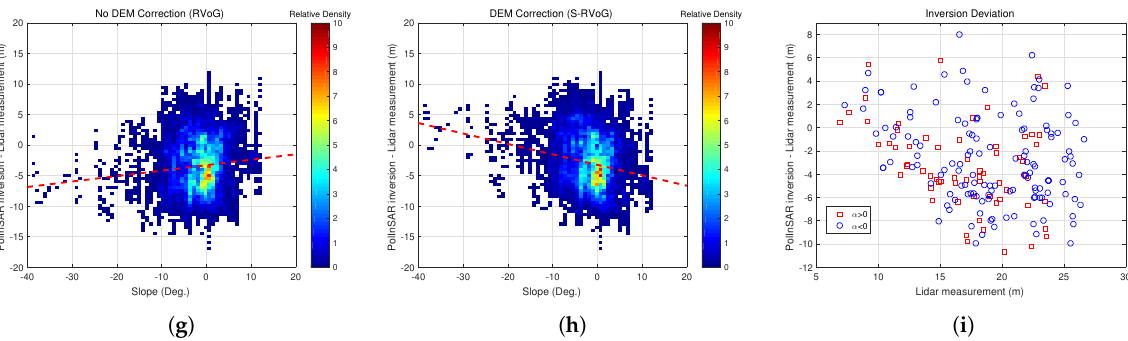
Figure 10. The forest height estimation of validation stands (corresponding to slope α > 0 deg) with the RVoG model ( a ) and the S-RVoG model ( b ), compared with the lidar measurement. The forest height estimation of validation stands (corresponding to slope α < 0 deg) with the RVoG model ( d ) and the S-RVoG model ( e ), compared with the lidar measurement, respectively. The color of the dots represents the terrain slope. ( c ) The histogram of the difference between the PolInSAR inversion and lidar measurement with the RVoG model and the S-RVoG model, respectively. The stands that are counted correspond to the stands in ( a , b ). ( f ) The histogram of the difference between the PolInSAR inversion and lidar measurement with the RVoG model and the S-RVoG model, respectively. The stands that are counted correspond to the stands in Figure 10d,e. ( g ) The slope versus height difference between the PolInSAR inversion without terrain correction and the lidar measurement. ( h ) The slope versus height difference between the PolInSAR inversion with terrain correction and the lidar measurement. The red dashed lines in Figure 10g,h are acquired by a linear fitting of all the density points. ( i ) The deviation between the S-RVoG model inversion and the lidar